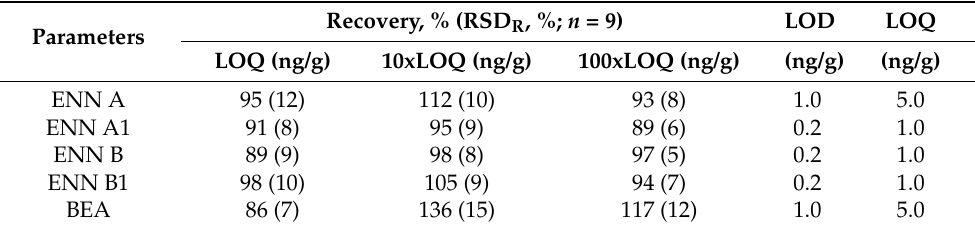
Table 2. The method